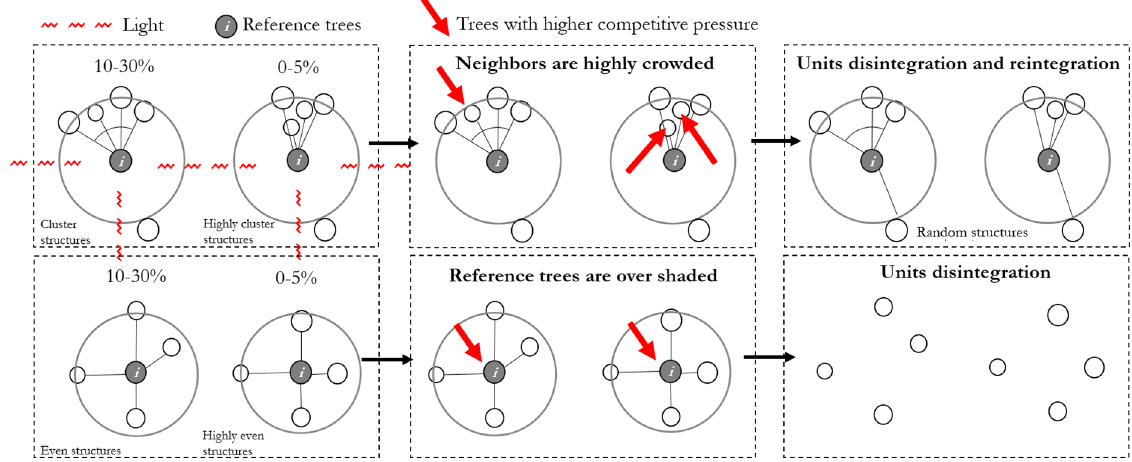
Figure 12. Disintegration – reintegration process of different structural units. Numbers present the proportion of varying structural units in natural forests.